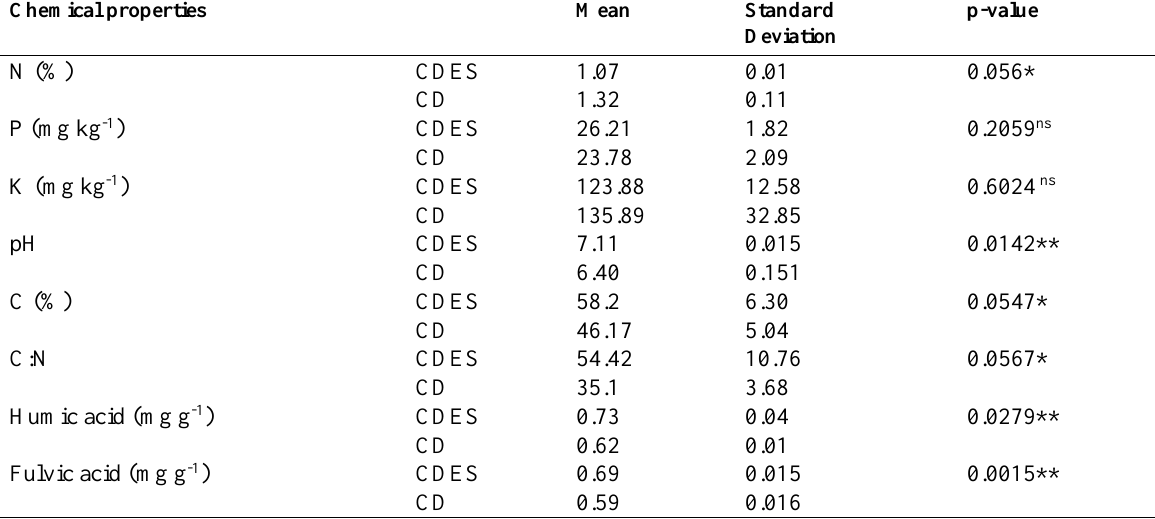
Table 1 Statistical analysis (t Test) of final chemical composition Chemical properties